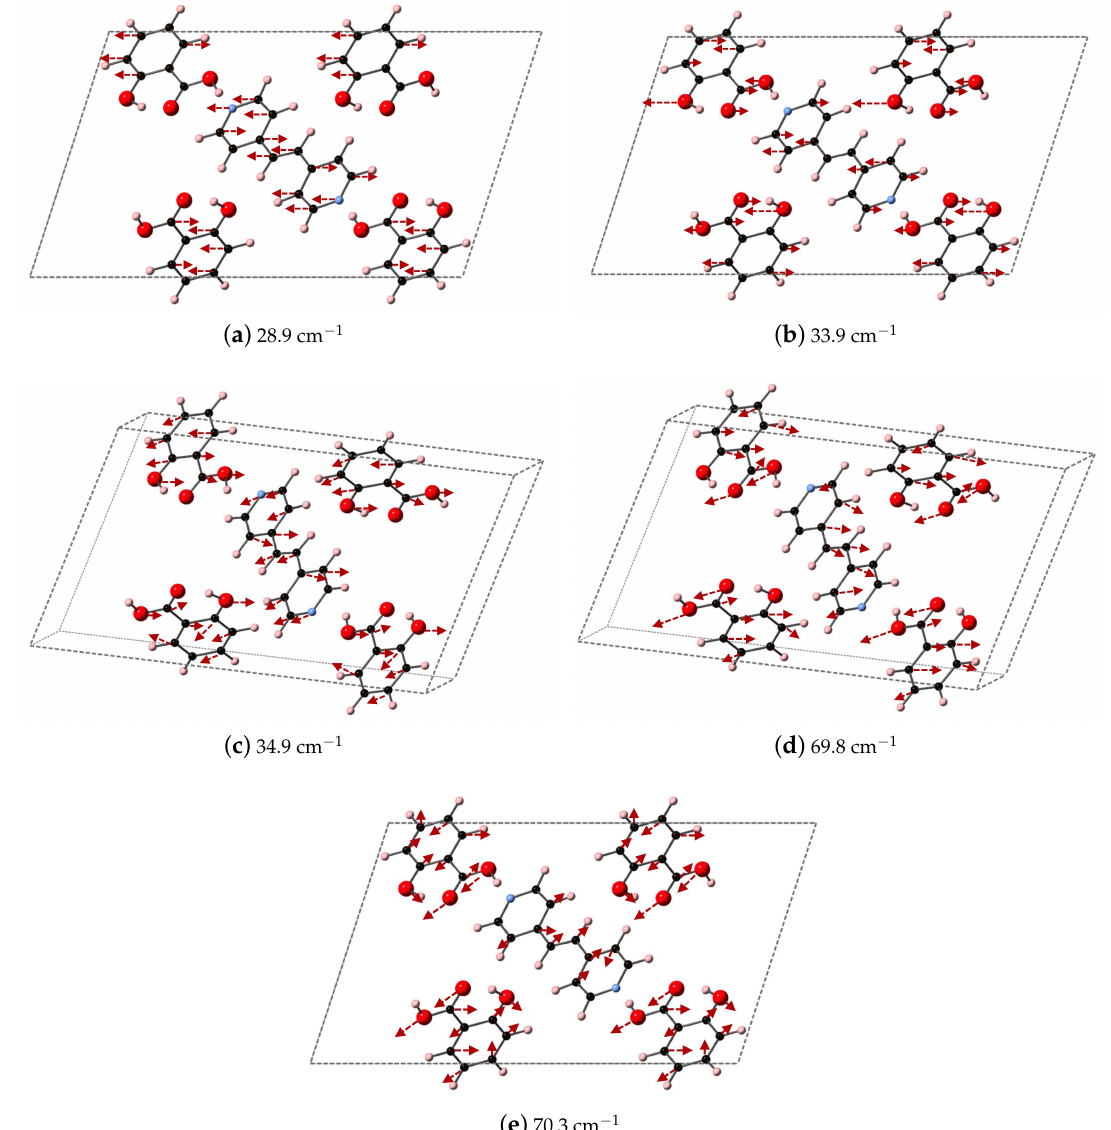
Figure 12. Plotted here are the DFT-D computed IR active modes of 2(SA) · BPE-I that occur at ( a ) 28.9 cm − 1 (along xz ); ( b ) 33.9 cm − 1 (along xz ); ( c ) 34.9 cm − 1 (along y ); ( d ) 69.8 cm − 1 (along y ); and ( e ) 70.3 cm − 1 (along xz